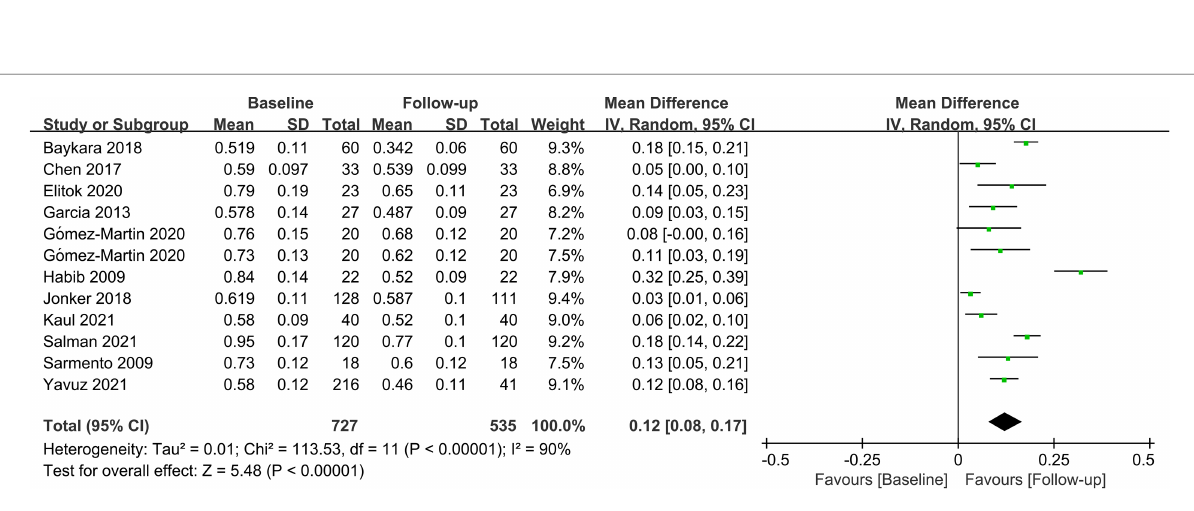
FIGURE 3 Forest plot of meta-analysis of CIMT at 12 months after bariatric surgery. (Gómez-Martin 2020 included two subsets of data for meta-analysis).